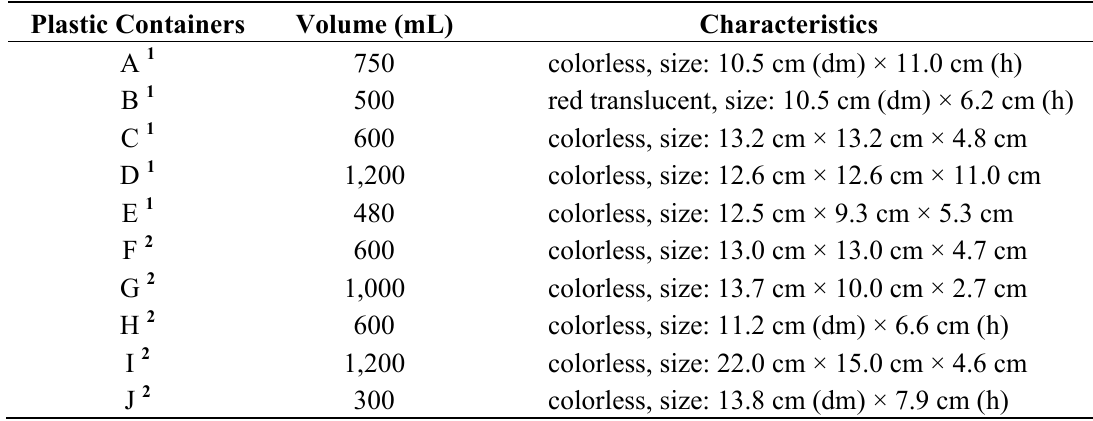
Table 1. Characteristics of the plastic containers that were